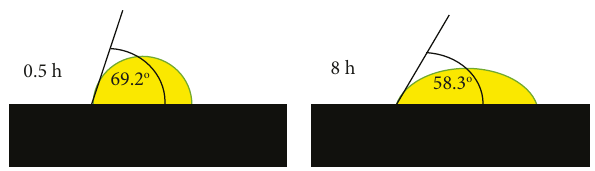
Figure 3: The water contact angle at 0.5h and